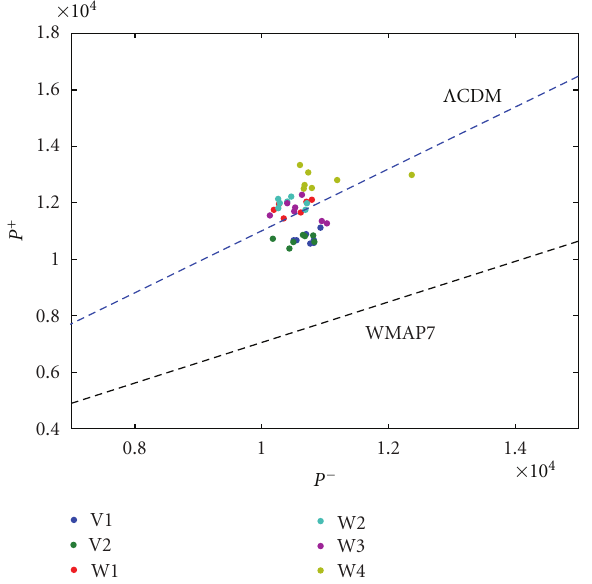
Figure 11: P + and P − of the WMAP team’s simulation for V and W band